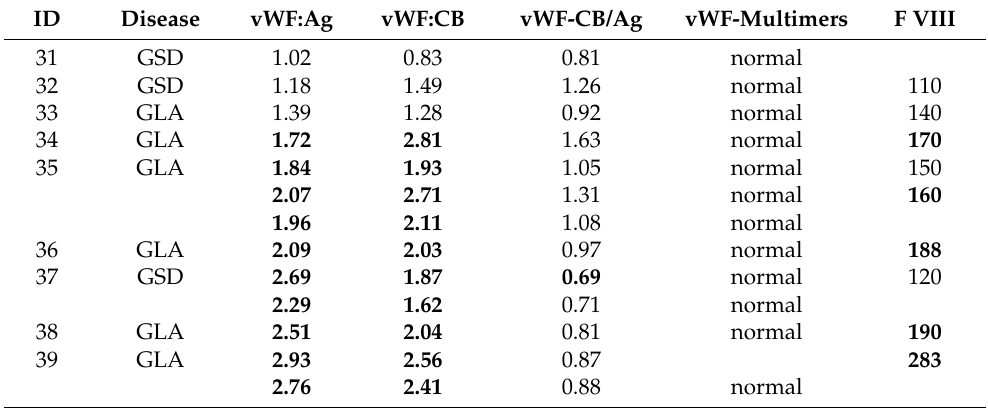
Table 4. Details von vWF parameters in patients with CLA. Bold font was used to label abnormal values.